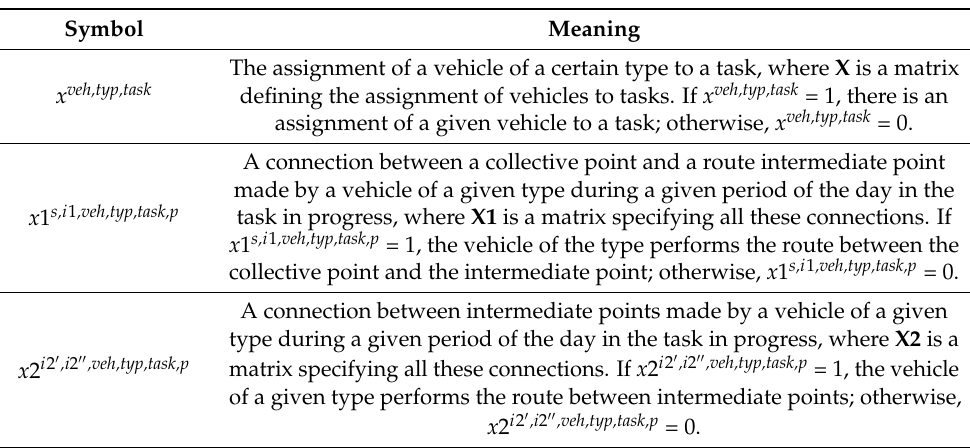
Table 2. Decision variables of the